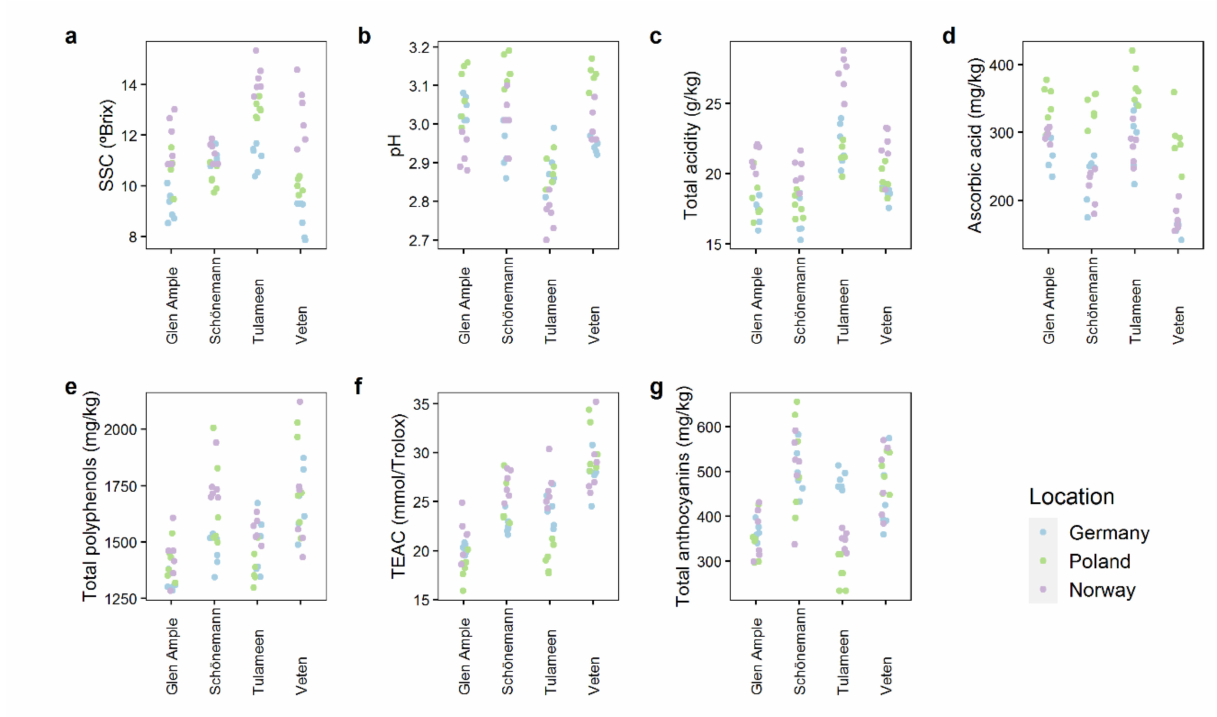
Figure 1. Soluble solid content (SSC) ( a ), pH ( b ), total acidity ( c ), ascorbic acid content ( d ), total polyphenols ( e ), Trolox equivalent antioxidant capacity ( f ), and total anthocyanins ( g ) of the fruits of the different raspberry genotypes. Each dot represents an individual sample, with color denoting the harvest location. The data represent two independent